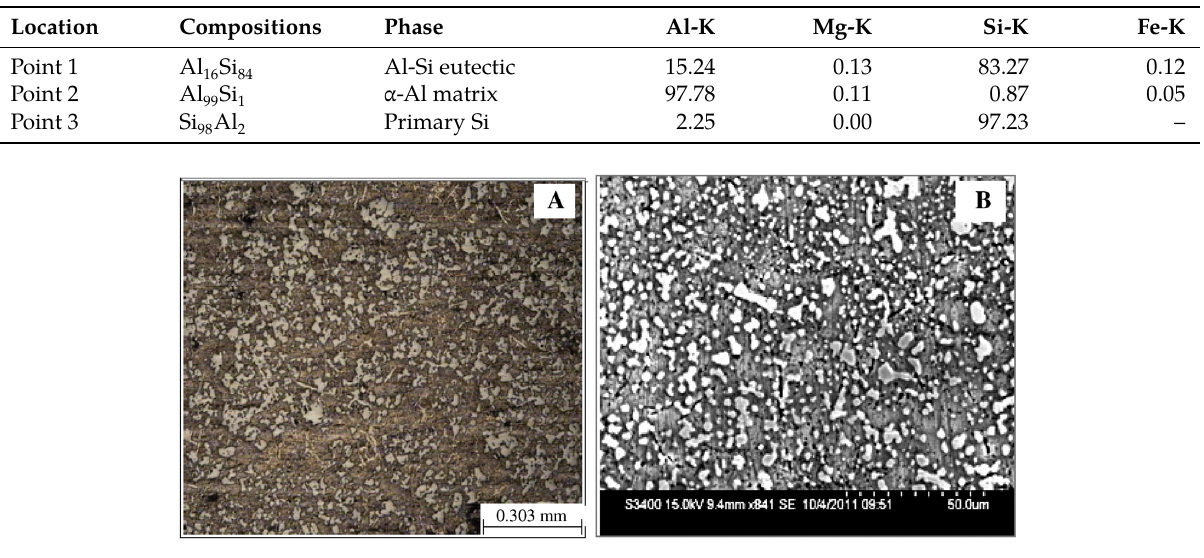
Figure 4: Microstructure of the SD+HC alloy (A) optical and (B) SEM.